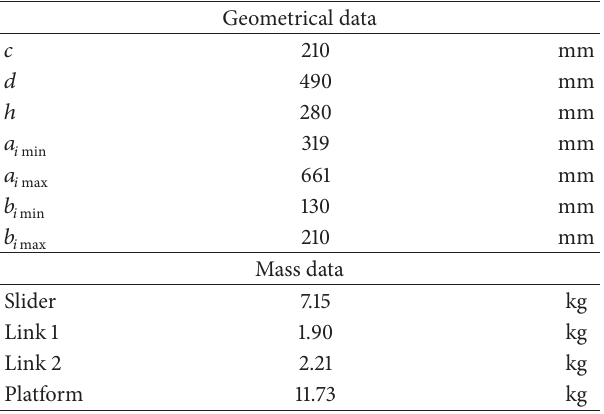
Table 3: Mechanical data of the robot